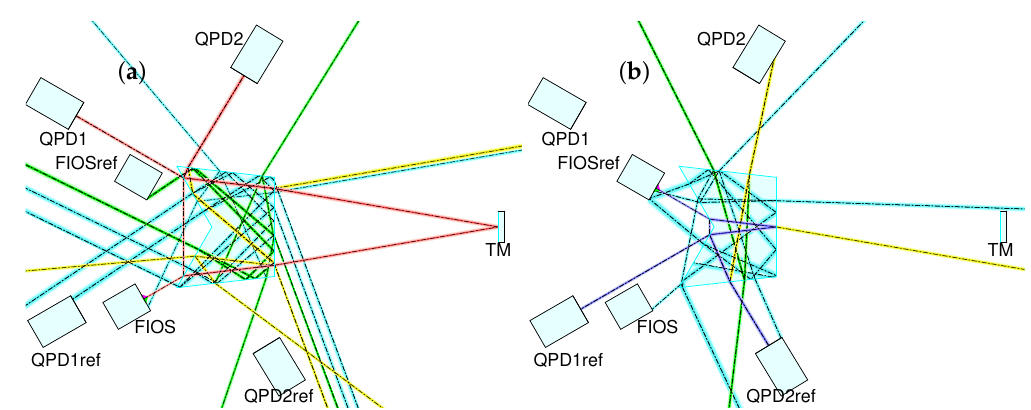
Figure A1. Ghost beam suppression in TM IFO ( a ) and Ref IFO ( b ). Absolute errors of 10 − 2 are introduced in the power transmission coefficient of each surface, and ghost beams down to a power threshold of P ghost / P nom. > 10 − 12 relative to the nominal beam power are considered. The nominal beams in the TM IFO and Ref IFO are drawn in red and blue, respectively. Ghost beams with 1 > P ghost / P nom. > 10 − 3 (yellow), 10 − 3 > P ghost / P nom. > 10 − 7 (green) and 10 − 7 > P ghost / P nom. > 10 − 12 (cyan) relative power level are depicted.